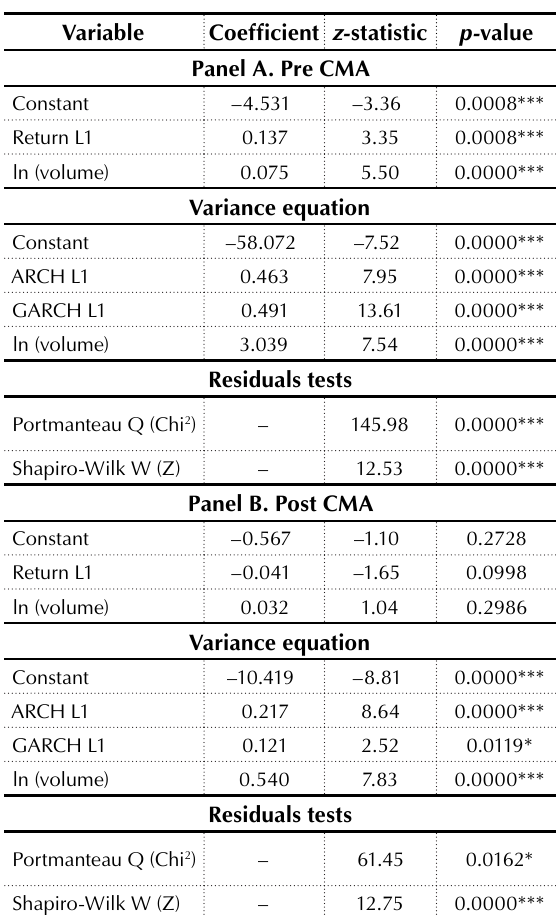
Table 6. GARCH (1,1) of volume, return relation in